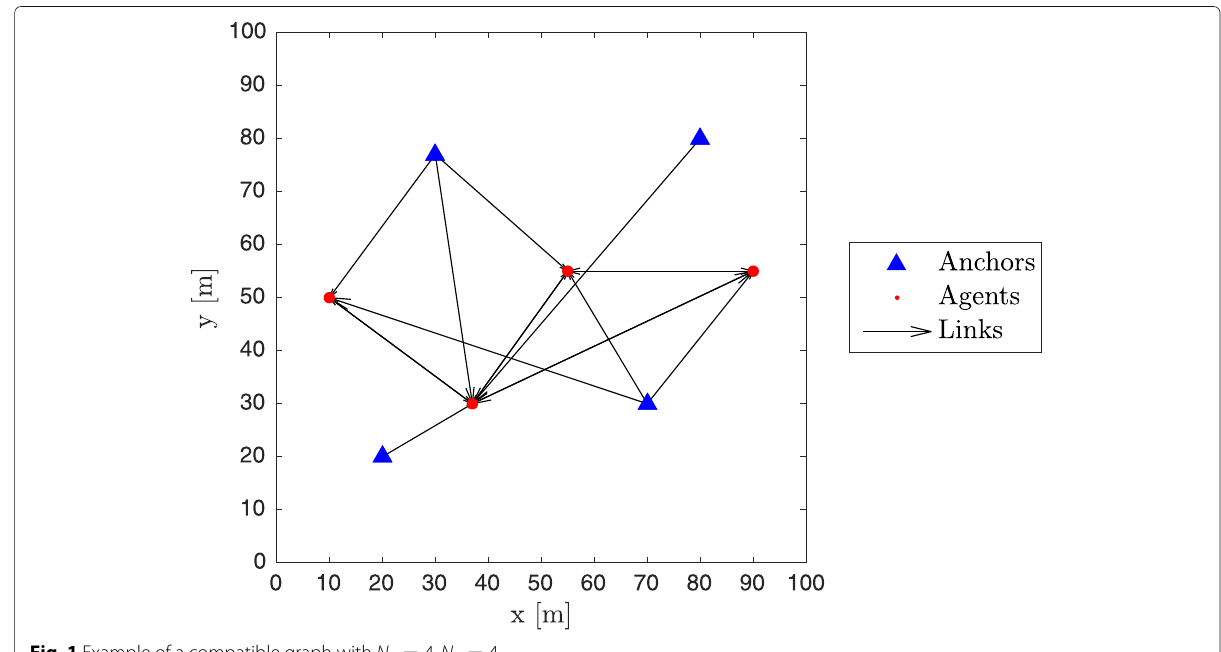
Fig. 1 Example of a compatible graph with N a = 4, N u = 4